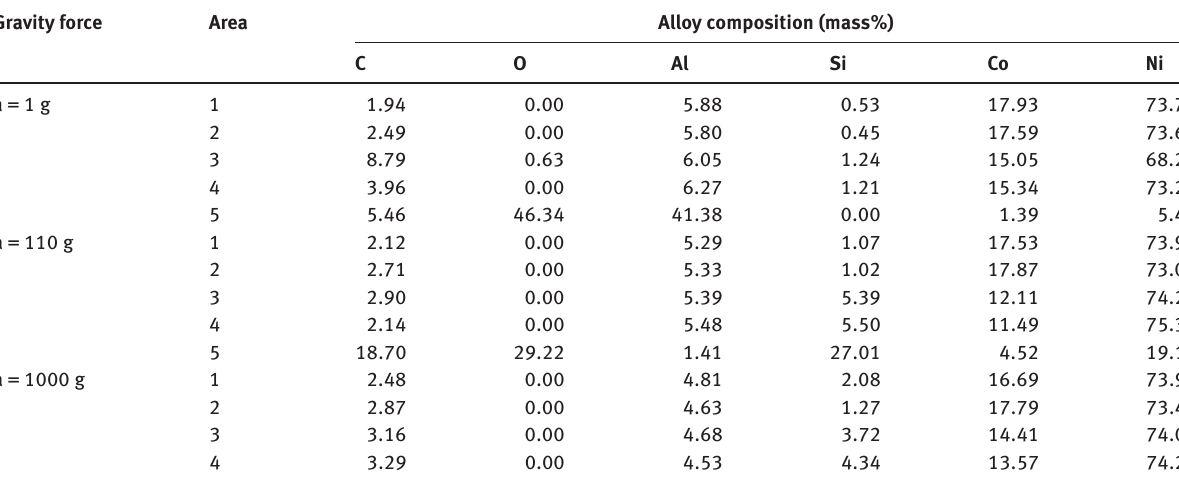
Table 5. SEM/EDS analysis results of obtained SHS alloys under high artificial gravity conditions for estimated composition of 5Al-20Co-75Ni